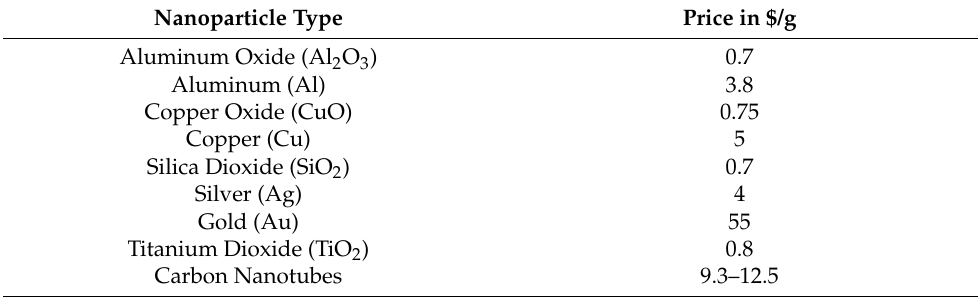
Table 4. Indicative prices of most common nanoparticles in $/g [122].